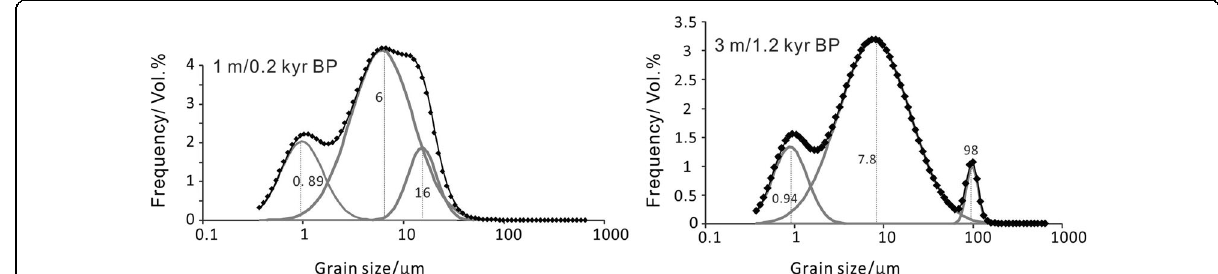
Fig. 2 Typical grain size distributions of the MD06-3040 core sediments at a depth interval of 1 m (0.2 kyr BP) and 3 m (1.2 kyr